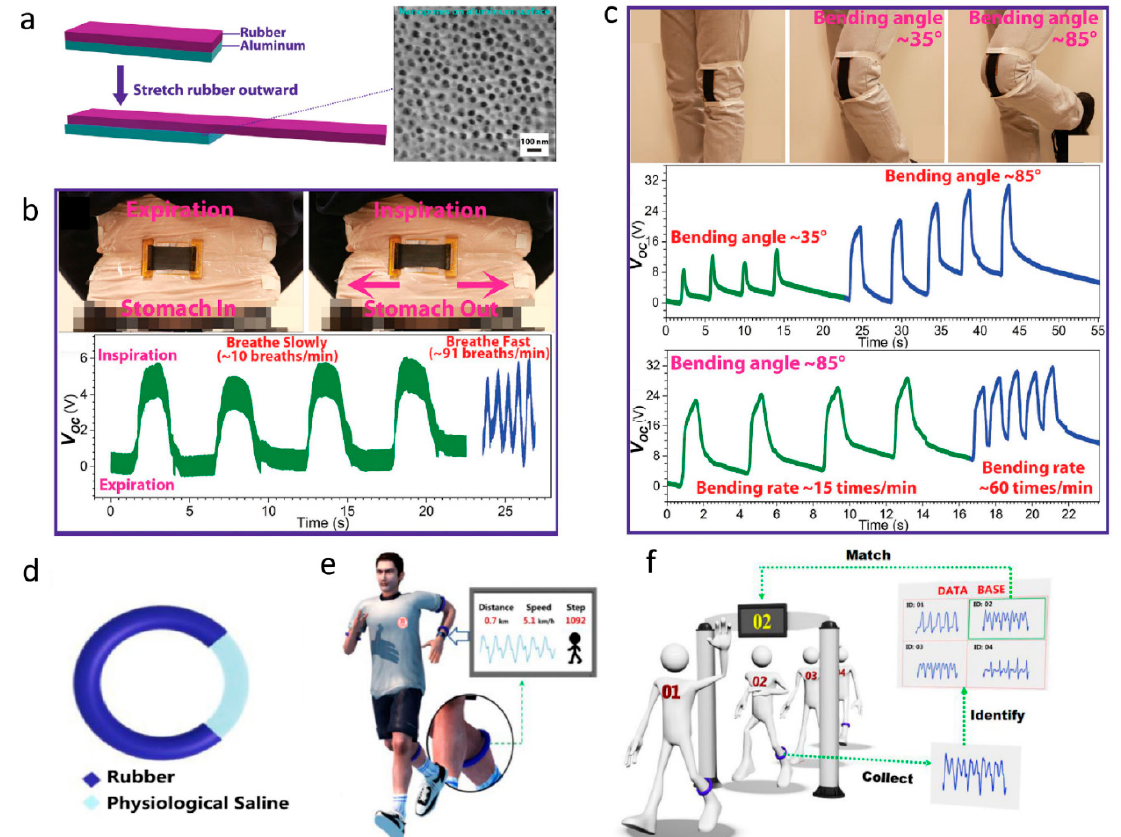
Figure 1. ( a ) Device structure of the stretchable-rubber-based triboelectric nanogenerator (TENG). ( b ) Images and electrical outputs of the TENG on the abdomen during expiration and